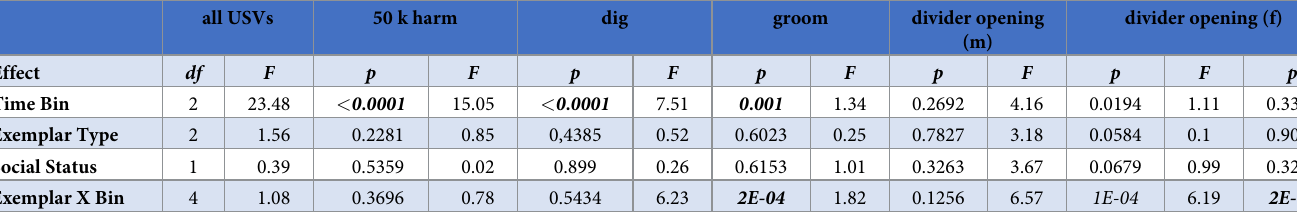
Table 1. Output of a general linear mixed model assessing the effects of BBV playback. all